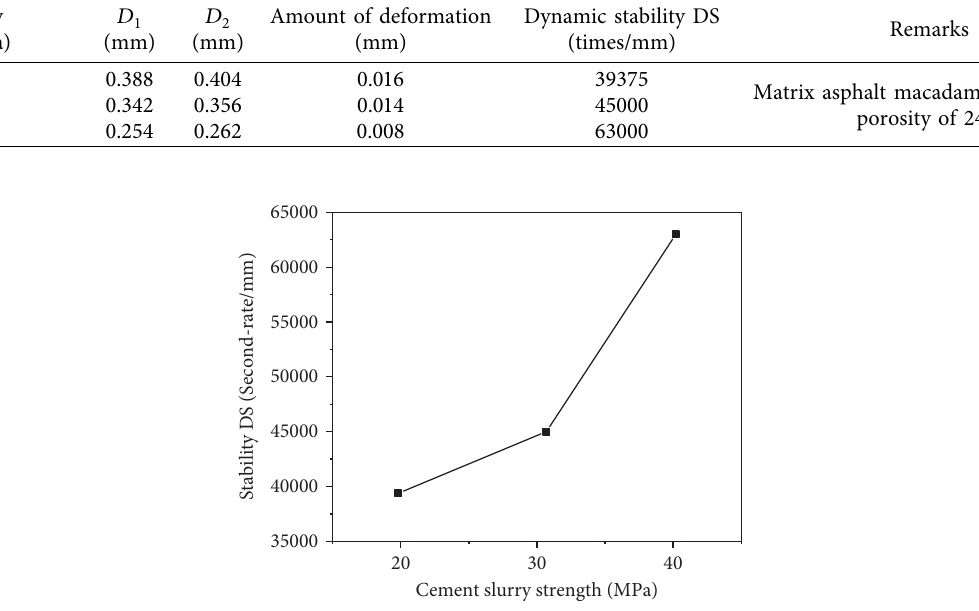
Figure 17: Variation curve of dynamic stability with cementitious mortar strength.